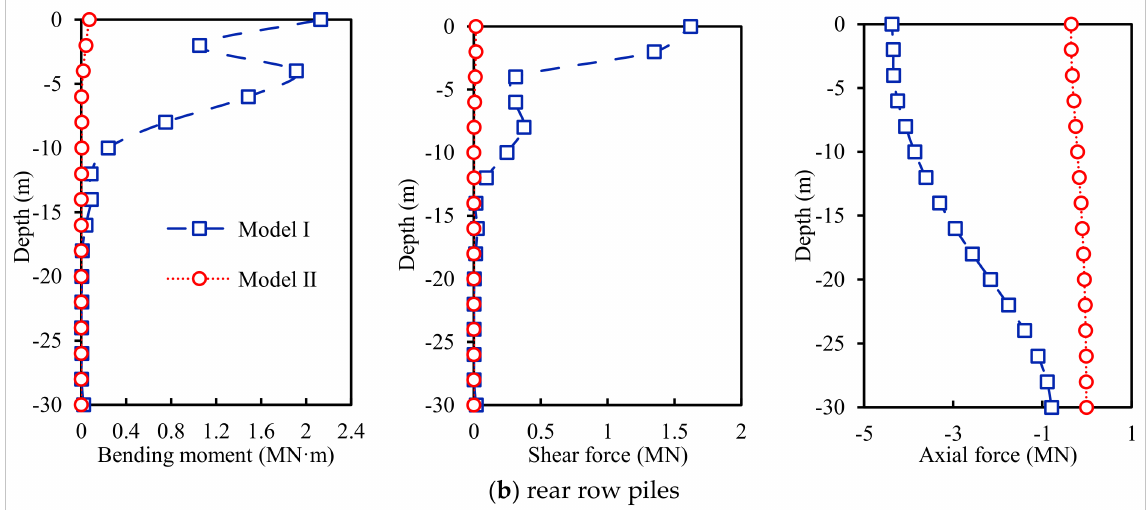
Figure 14. Envelope of bending moment, shear force and axial force (under Borrego Mountain record).